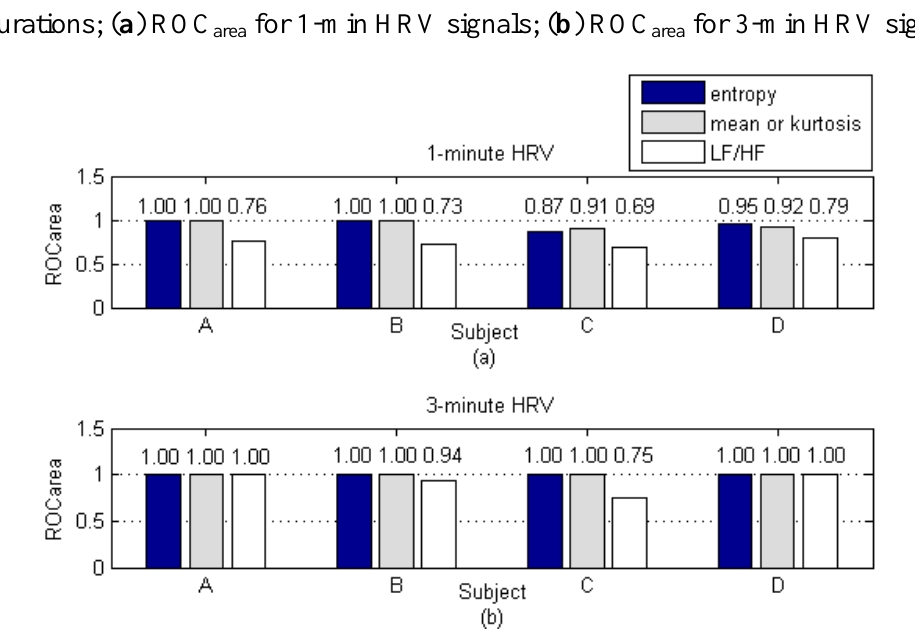
Figure 10. Comparison of LF/HF and wavelet-based features based on 1-min and 3-min